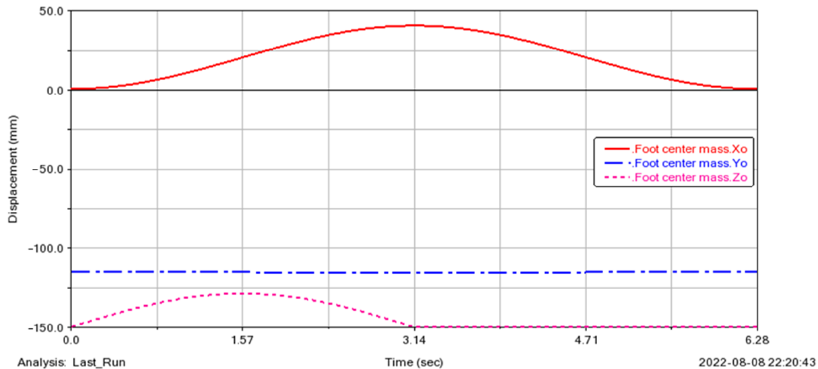
Figure 11. Simulation prediction of robot foot trajectories.